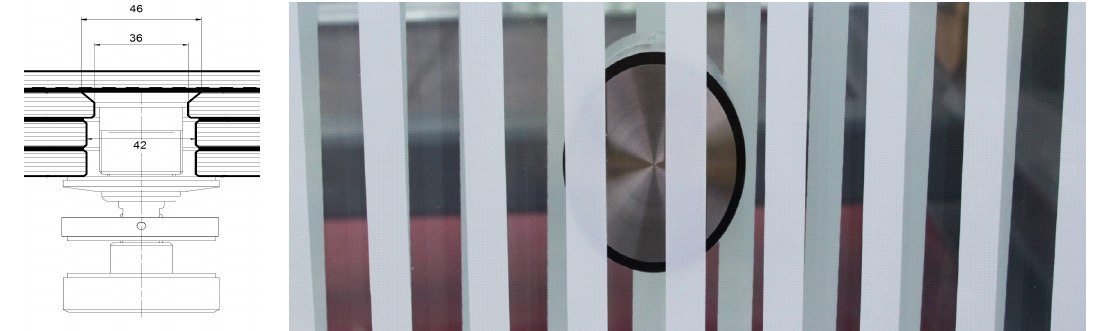
Fig. 4 laminated countersunk point fixing in the roof glass